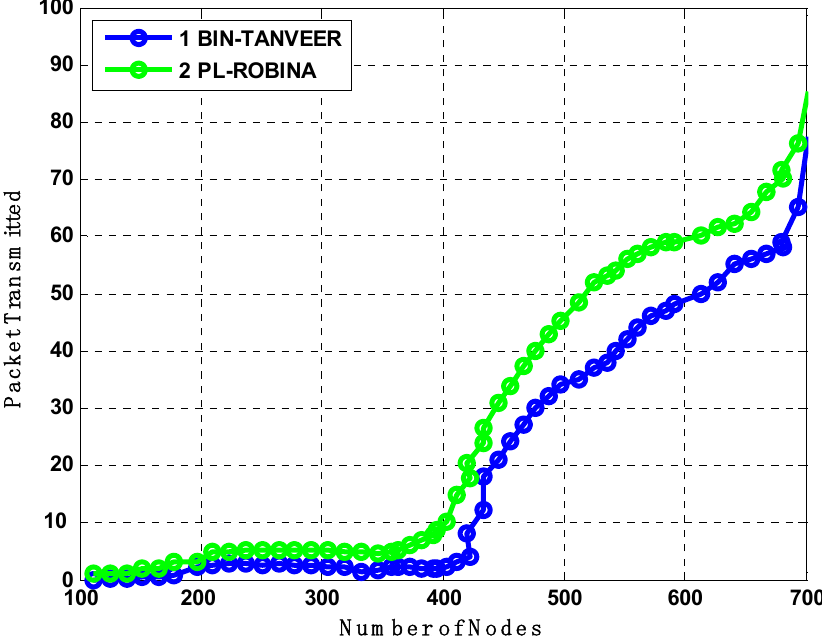
Figure 17. Analysis of packet transmission compared with BIN-TANVEER and PL-ROBINA.